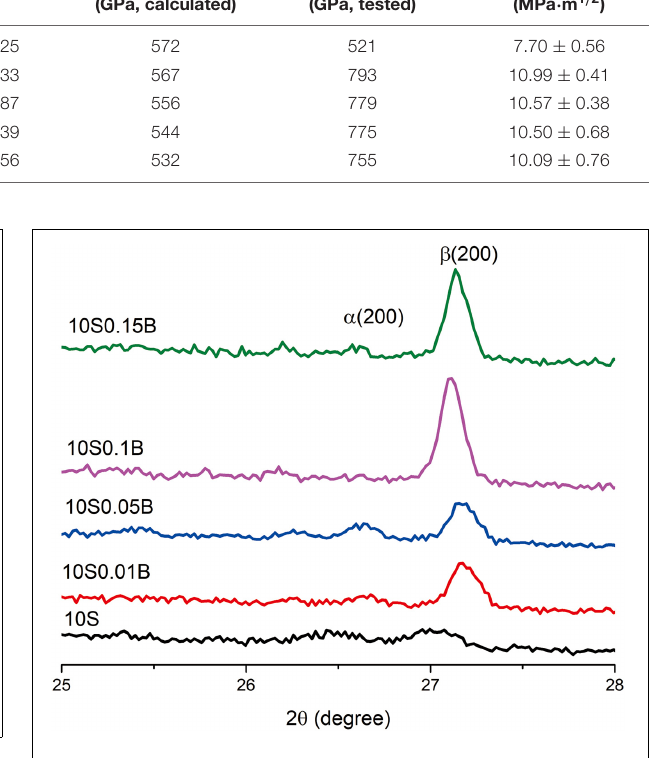
FIGURE 3 | XRD patterns for α -Si 3 N 4 (100) and β -Si 3 N 4 (200) crystal planes of the composite